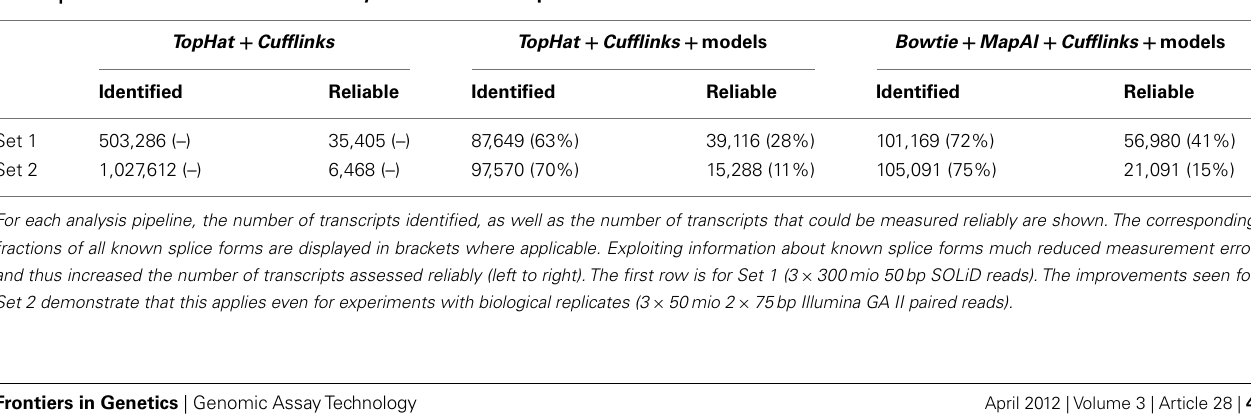
Table 2 | Statistics of identified and reliably measured